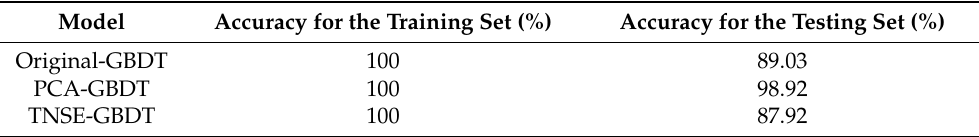
Table 5. The classification results for the training and testing sets based on GBDT models. Model